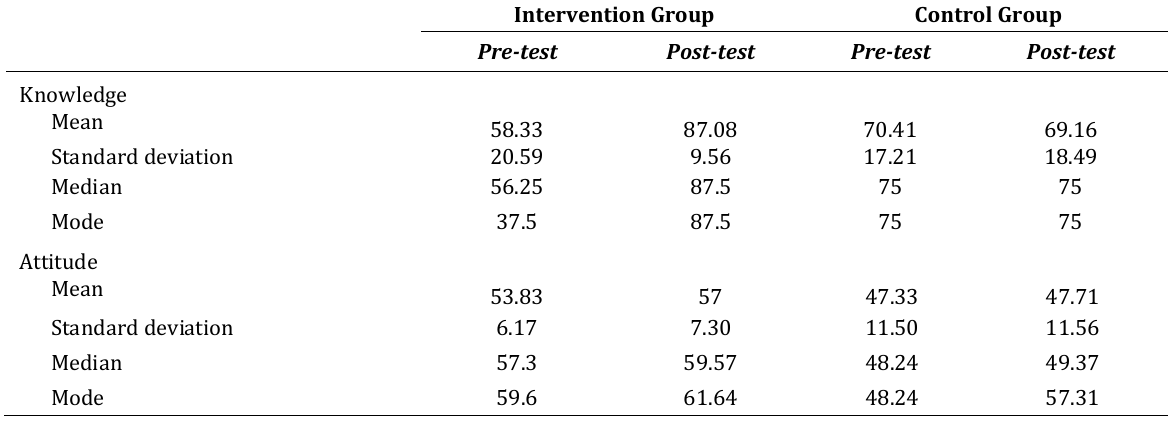
Table 2 - Knowledge and Attitude Scores of the Control and Intervention Groups Intervention